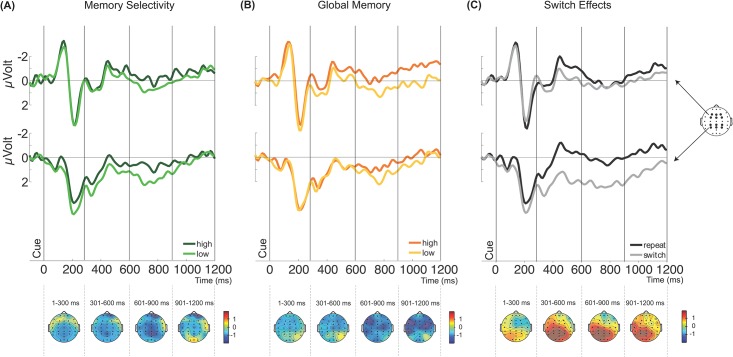
Cue-locked potentials for Memory Selectivity, Global Memory, and Switching, measured at the frontal electrodes F3, FZ, F4, FC3, FCZ, and FC4 (upper) and posterior electrodes CP3, CPZ, CP4, P3, PZ, and P4 (lower), as well as topographic maps.(A) Top: ERP waveforms for high and low memory selectivity trials, both time-locked to the onset of the cue. Bottom: The scalp topography of the average signal differences between high and low memory selectivity trials in steps of 300 ms starting with cue-onset. (B) Top: ERP waveforms for high and low global memory trials, both time-locked to the onset of the cue. Bottom: The scalp topography of the average signal differences between high and low global memory trials in steps of 300 ms starting with cue-onset. (C) Top: ERP wave forms for switch and repeat trials, both time-locked to the onset of the cue. Bottom: The scalp topography of the average signal differences between switch and repeat trials in steps of 300 ms starting with cue-onset. Plots show data collapsed across material and switching (A and B), and material (C).